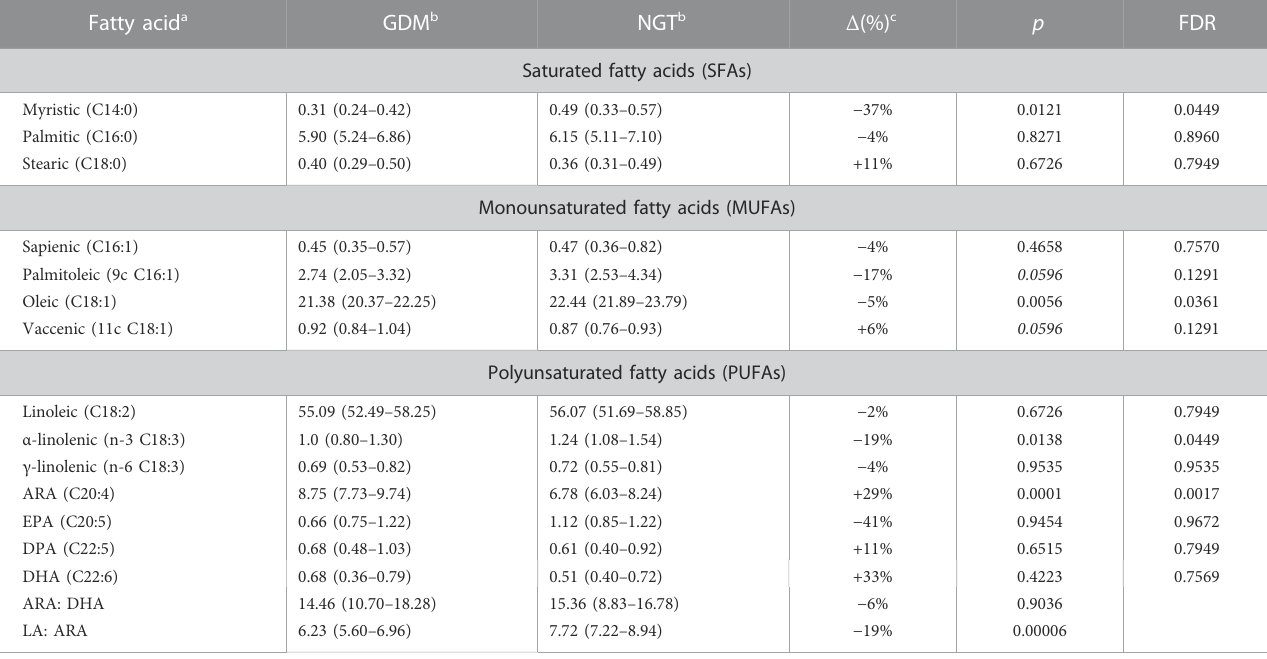
TABLE 3 Plasma cholesteryl ester pro fi ling using 14 fatty acids as a representative